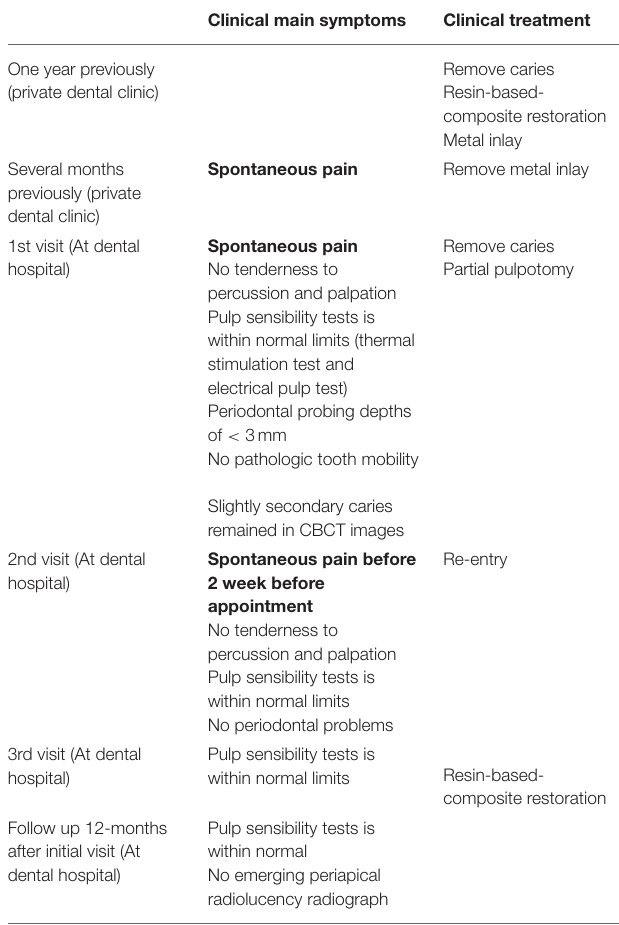
TABLE 1 | Timeline symptoms and treatment of maxillary second molar. Clinical main symptoms Clinical